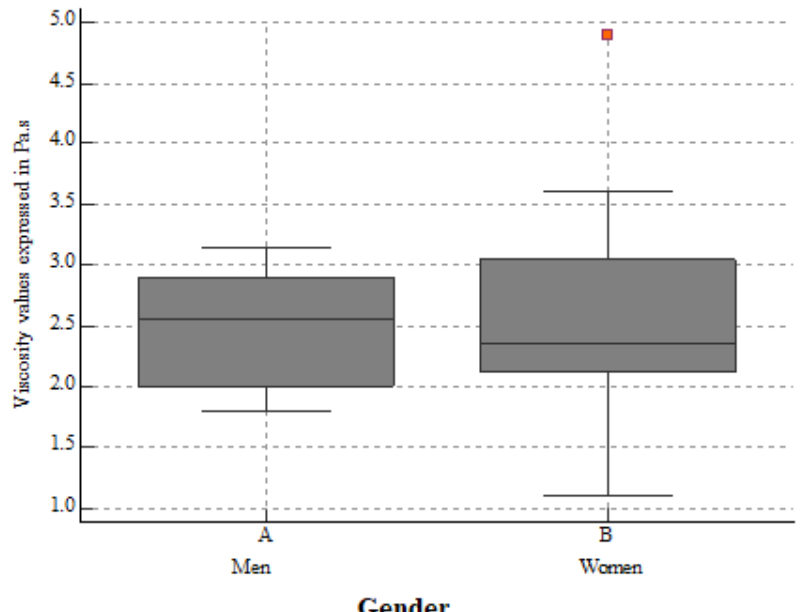
Figure 3. The mean kidney viscosity values in healthy men and women. No significant differences between Vi PLUS mean values were found ( p = 0.8964).